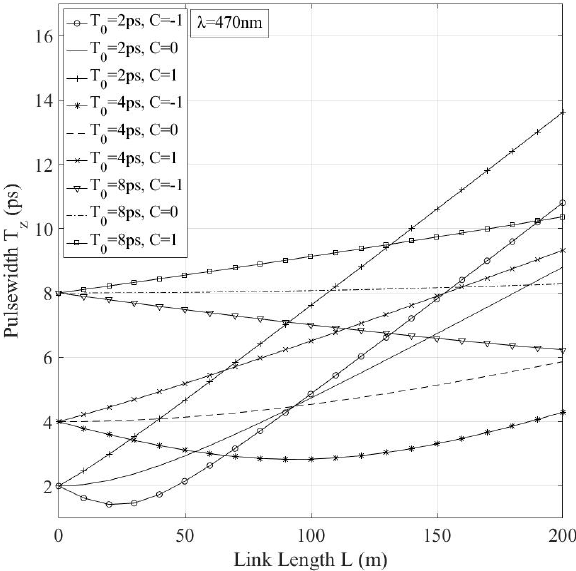
Figure 2. Pulsewidth versus propagation length for various initial pulsewidths and chirp values.